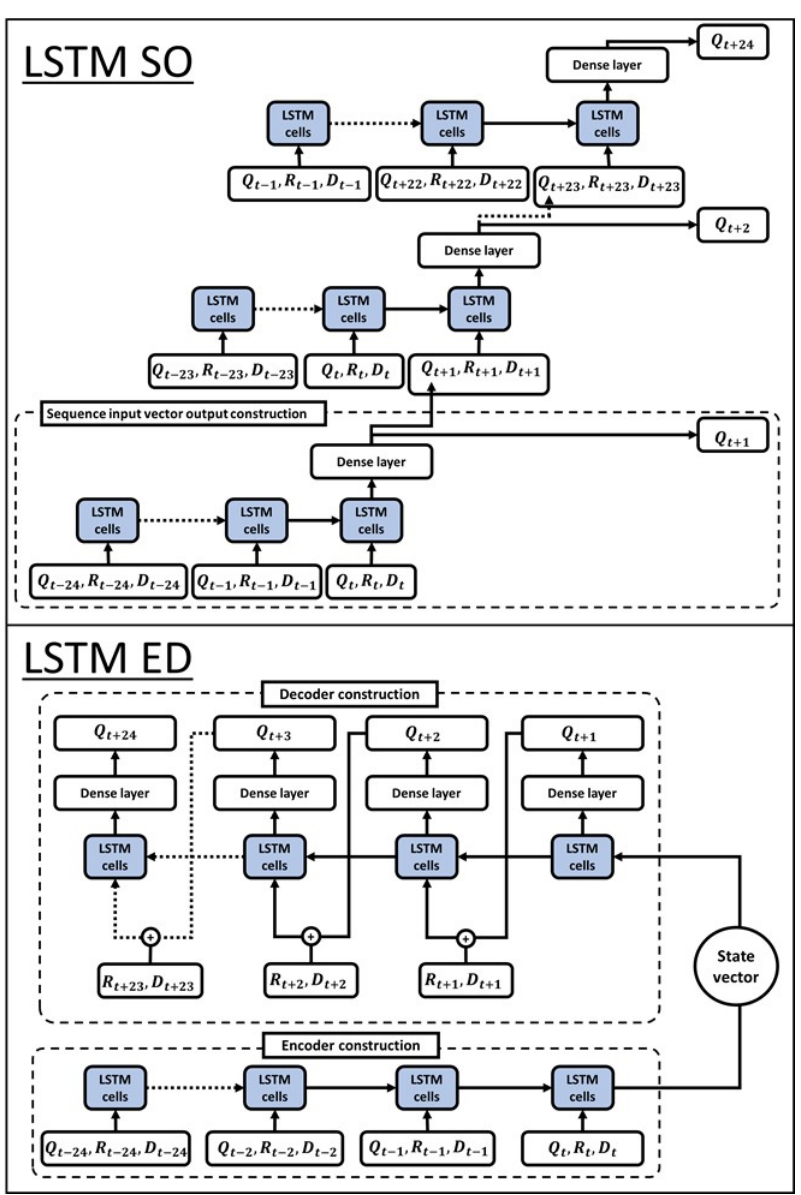
Figure 2. Structures of the LSTM SO (top diagram) and LSTM ED (bottom diagram) models for reservoir water level prediction.